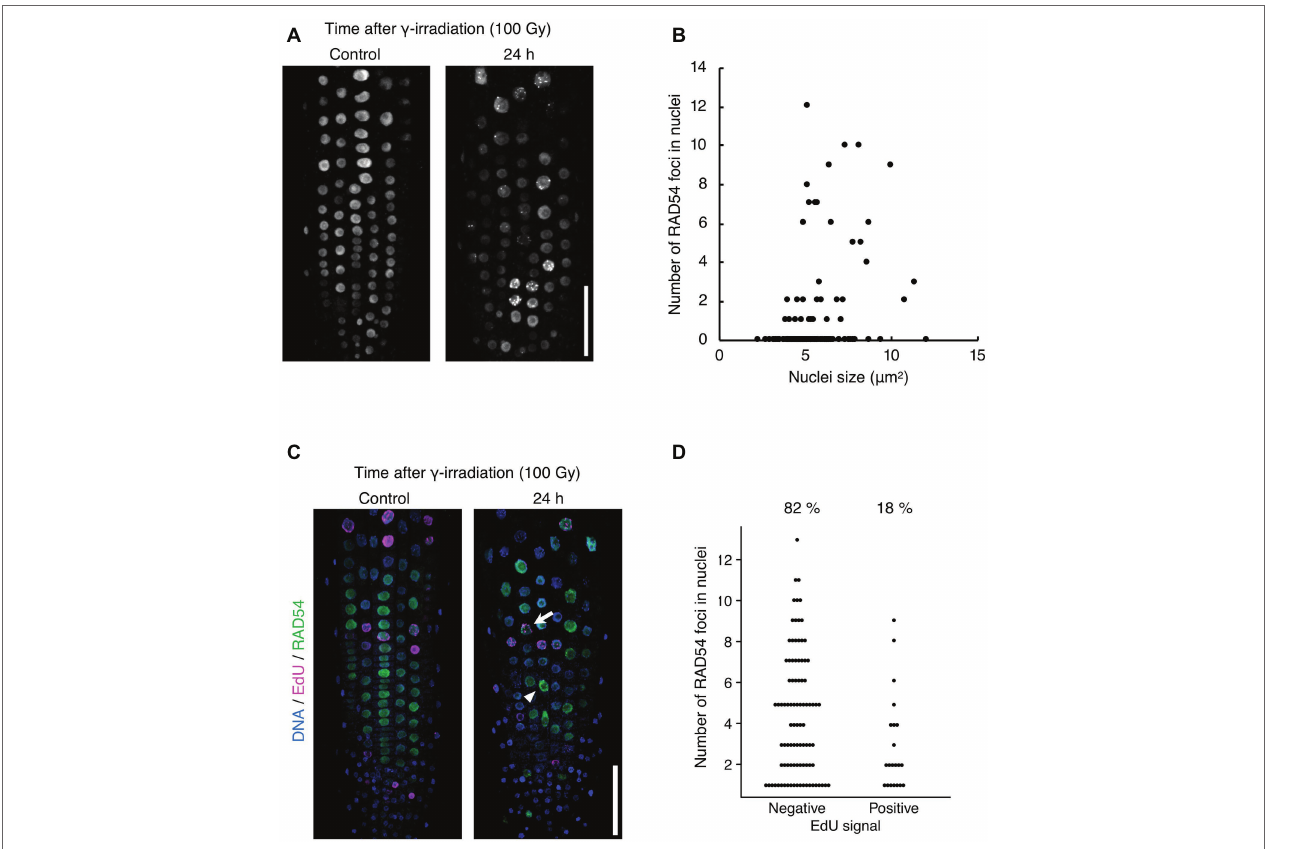
FIGURE 2 | RAD54 foci are detected with high frequency during G1 or G2 phase cells at long time after γ -irradiation. (A) Epidermis of the root meristematic zone of plants expressing RAD54-EYFP at 24 h after γ -irradiation. Scale bar: 50 μm. (B) Relationship between the number of RAD54 foci in nuclei and nucleus size. The correlation coefficient is 0.28 ( p < 0.01, n = 189). (C) Epidermis of the root meristematic zone in plants expressing RAD54-EYFP stained with DAPI and EdU at 24 h after γ -irradiation. Blue: DNA. Magenta: EdU. Green: RAD54-EYFP. White arrows and arrowheads indicate RAD54 foci positive cells labeled with EdU and RAD54 foci positive cells not labeled with EdU, respectively. Scale bar: 50 μm. (D) Number of RAD54 foci in cells negative and positive for EdU signals at 24 h after γ -irradiation (100 Gy). Seven roots were counted for each group. Cells lacking RAD54 foci were not counted. Upper percentages are the detection frequency of EdU-labeled cells and non-labeled cells showing RAD54 foci at 24 h after γ -irradiation. EdU negative: n = 93; EdU positive: n =